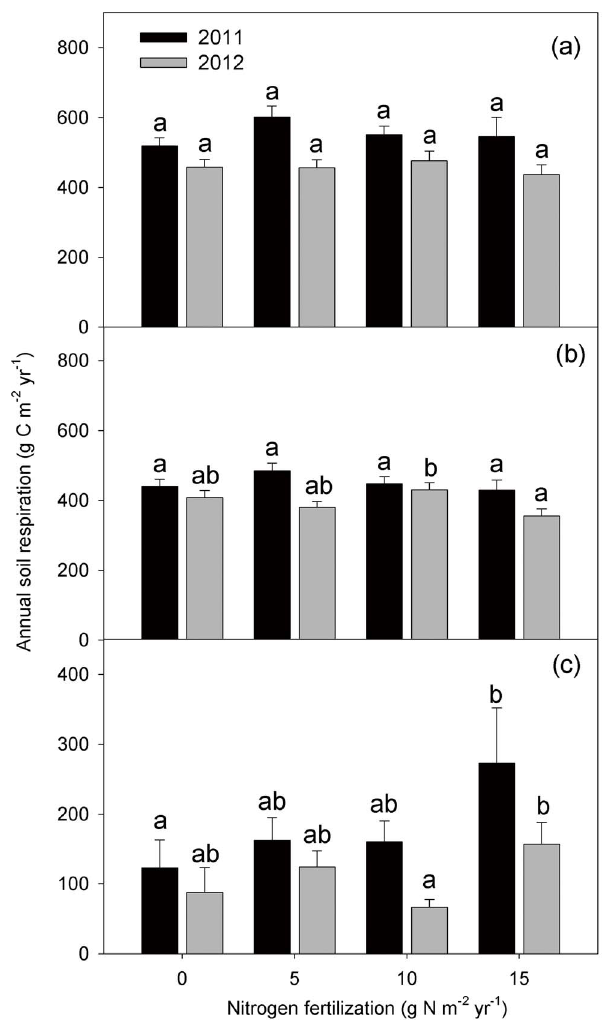
Figure 3. Comparison of annual soil respiration (a), autotrophic respiration (b), and heterotrophic respiration (c) among control, low-, medium-, and high-nitrogen (N) plots in 2011 (black) and 2012 (gray). Significant differences among N treatments are indicated by different letters.